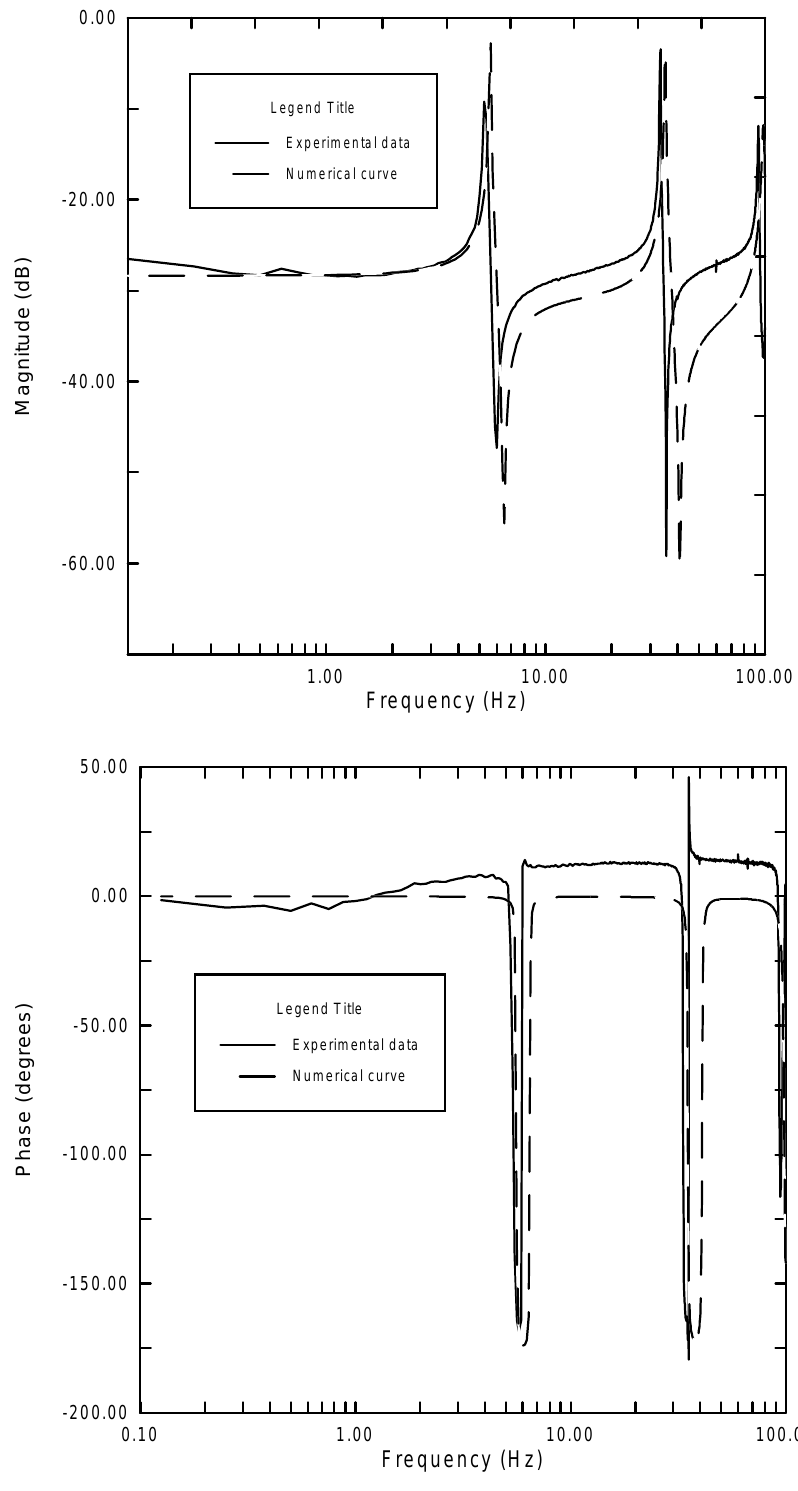
Fig. 11. Experimental and adjusted model transfer